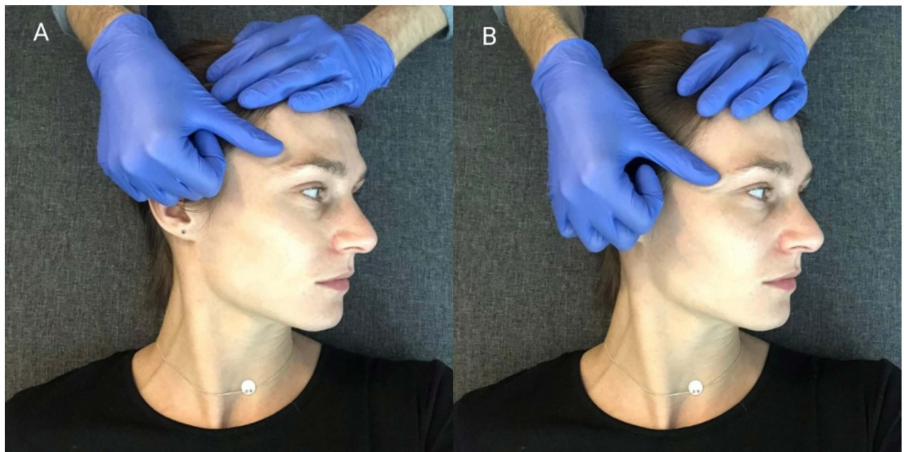
Figure 5. MR procedure of the muscle on the right side: ( A ) Locating the restrictions; ( B ) taking out the tissue slack.